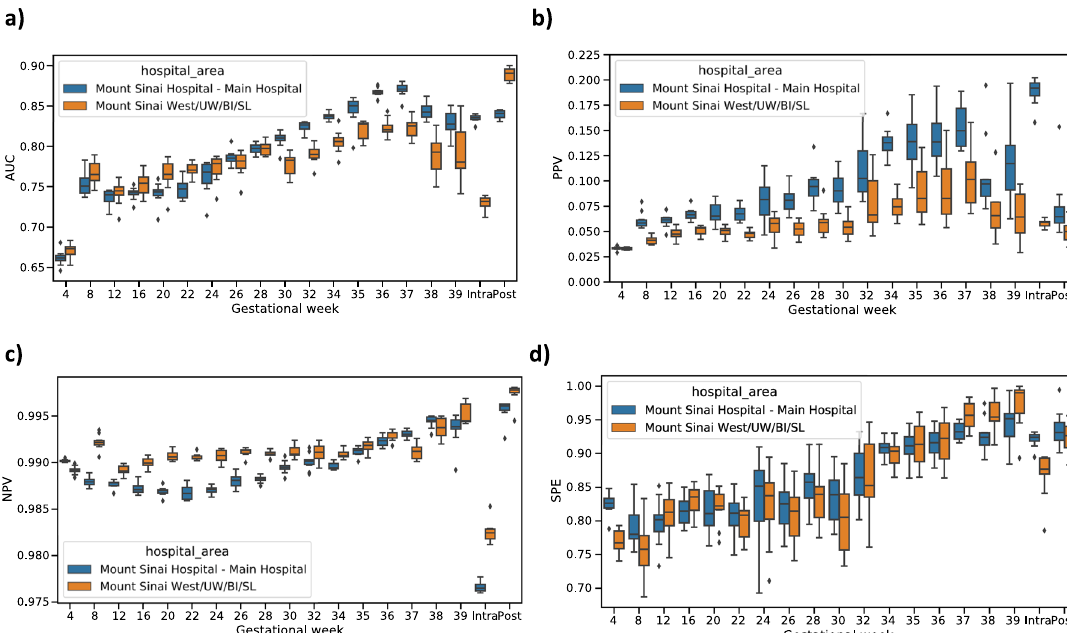
Fig. 7 Model validation on two independent datasets in MSHS. a Area under receiver operating characteristic curve (AUC) score for each time point. b Positive predictive value (PPV), along with preeclampsia risk in the population, at each time point. c Negative predictive value (NPV) at each time point. d Speci fi city (SPE) at each time point. Blue boxes indicate the validation in MSH testing set and yellow boxes represent the validation in MSW dataset. The median, interquartile (1st and 3rd) range, and minimum and maximum values, are depicted by the center line, the bounds of the boxes, and the whiskers